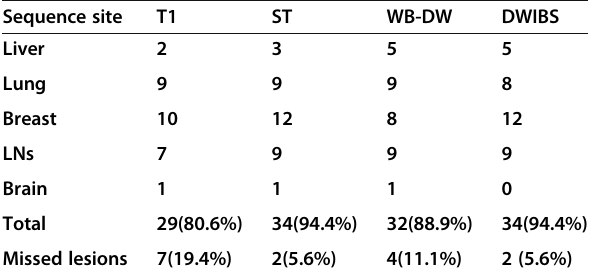
Table 7 Number and site distribution of metastatic soft tissue lesions detected by MRI sequences Sequence site